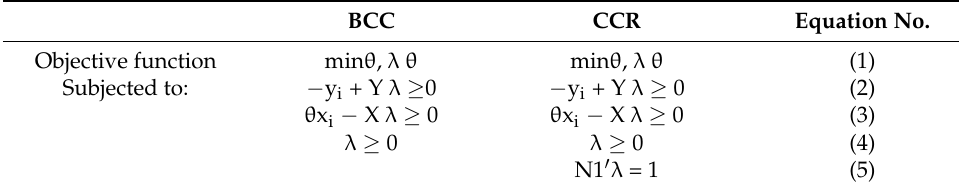
Table 3. BCC and CCR DEA